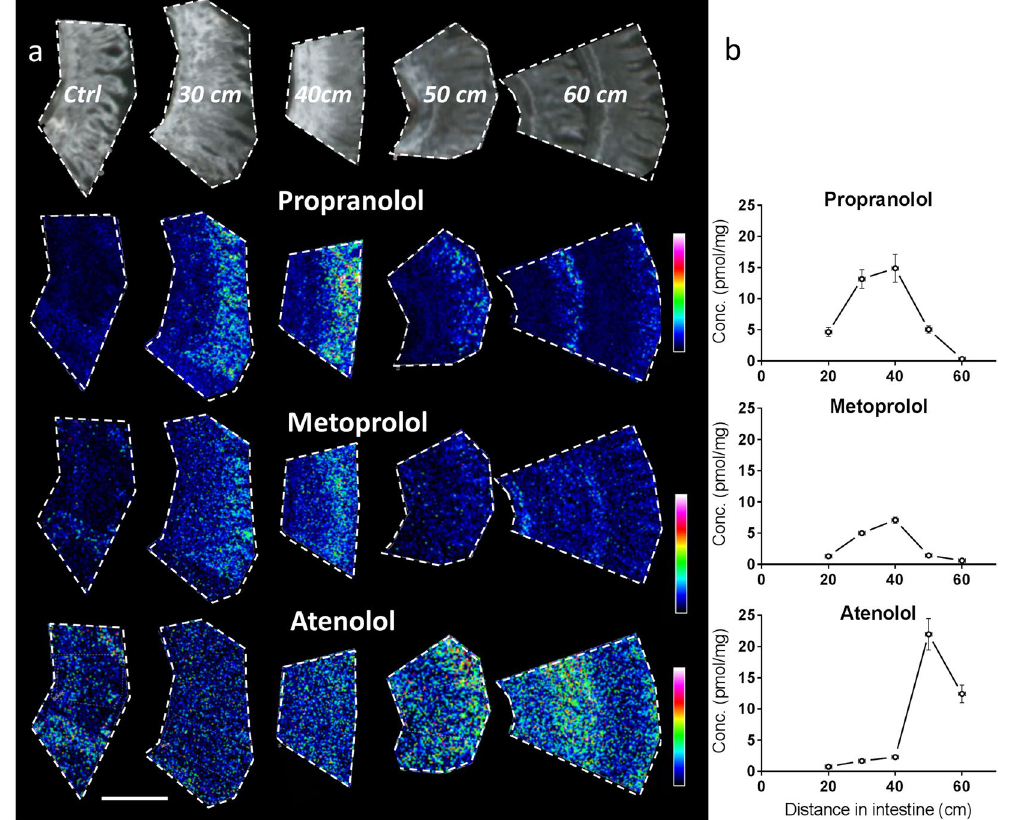
Figure 2. Longitudinal (proximal to distal) and crypt-villus distribution of test compounds in rat small intestine. Images and concentration determinations from samples collected 20 min post oral administration (1 µ mol/kg) at different distances distal from the pyloro-duodenal transition. ( a ) MALDI MSI ion distribution images of propranolol, metoprolol, and atenolol in intestine, scale bar is 1 mm. All tissue sections were analysed at the same occasion and each compound is displayed with its own relative intensity scale (rainbow). Propranolol intensity is scaled to 10% of max intensity, metoprolol intensity is scaled to 10% of max intensity, and atenolol intensity is scaled to 7% of max intensity. ( b ) Homogenate concentrations measured by LC-MS/MS for the three investigated compounds; propranolol, metoprolol, and atenolol. The graphs present mean concentrations and range of duplicate determinations, in some instances error bars are shorter than height of symbols. X-error bars indicate position of the sampling + / − 1 cm distal from the pyloro-duodenal